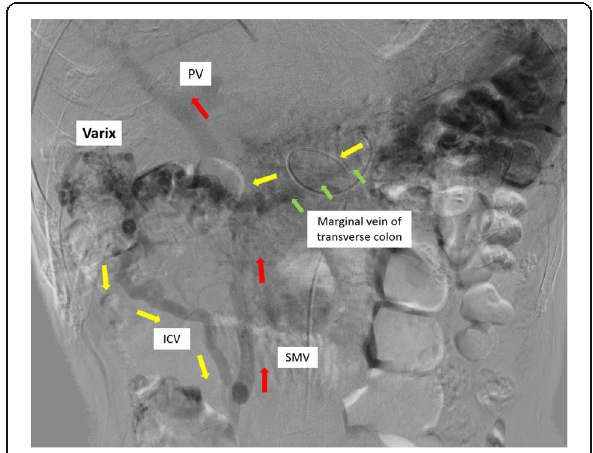
Fig. 3 Findings of trans-splenic arterial splenic venography. A route (red arrow) was formed from the marginal vein of the transverse colon (green arrow), via the ICV, into the superior mesenteric vein (yellow allow) and back to the portal vein. PV, portal vein; SMV, superior mesenteric vein; ICV, ileocolic